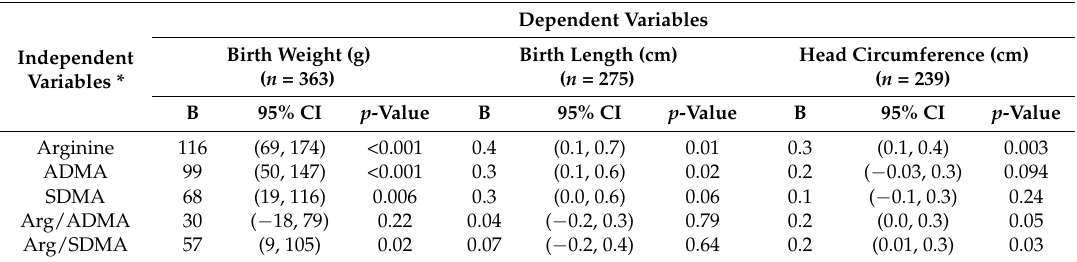
Table 3. Arginine and metabolites in the amniotic fluid as determinants of birth weight, length, and head circumference by multiple linear regression.